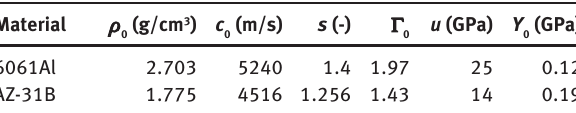
Table 1: The physical and equation of state (EOS) parameters of two metals.